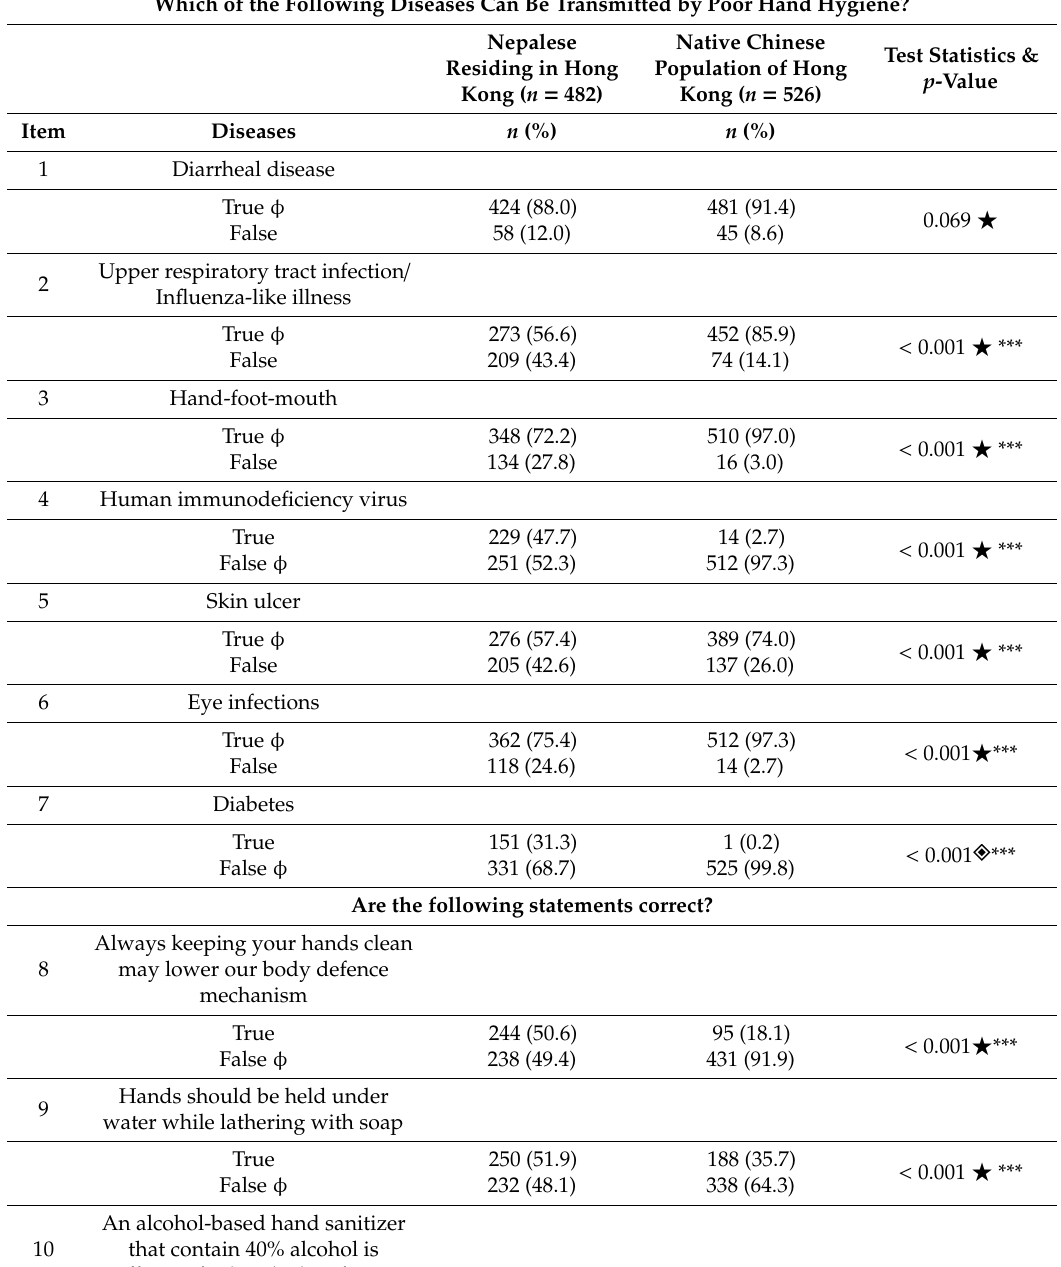
Table 2. Knowledge level on hand hygiene (0 to 12).